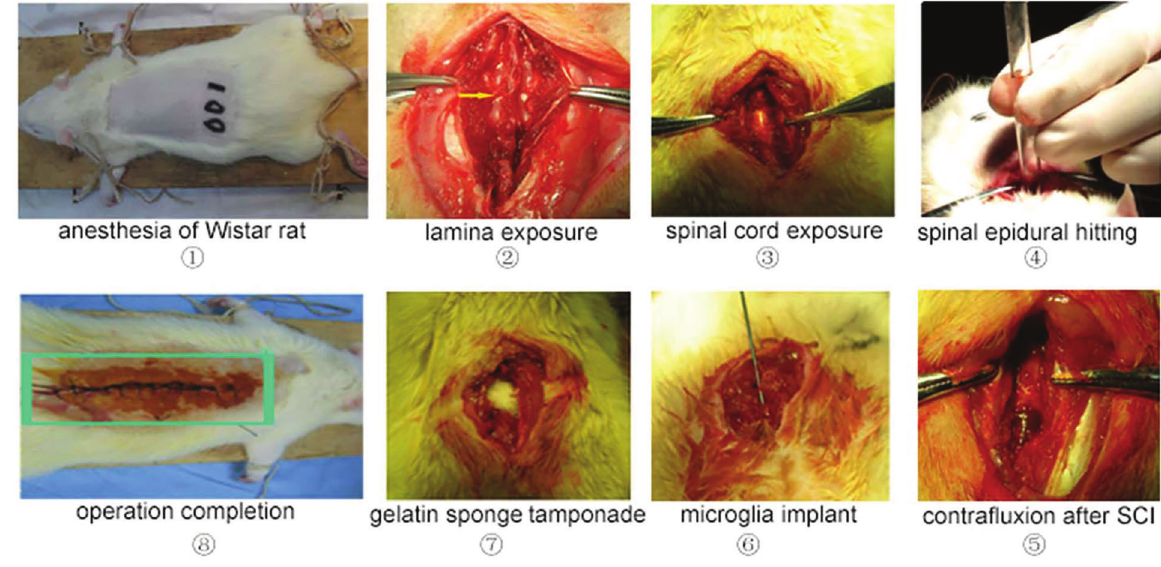
Figure 2. Process used to establish the rat model of spinal cord injury.